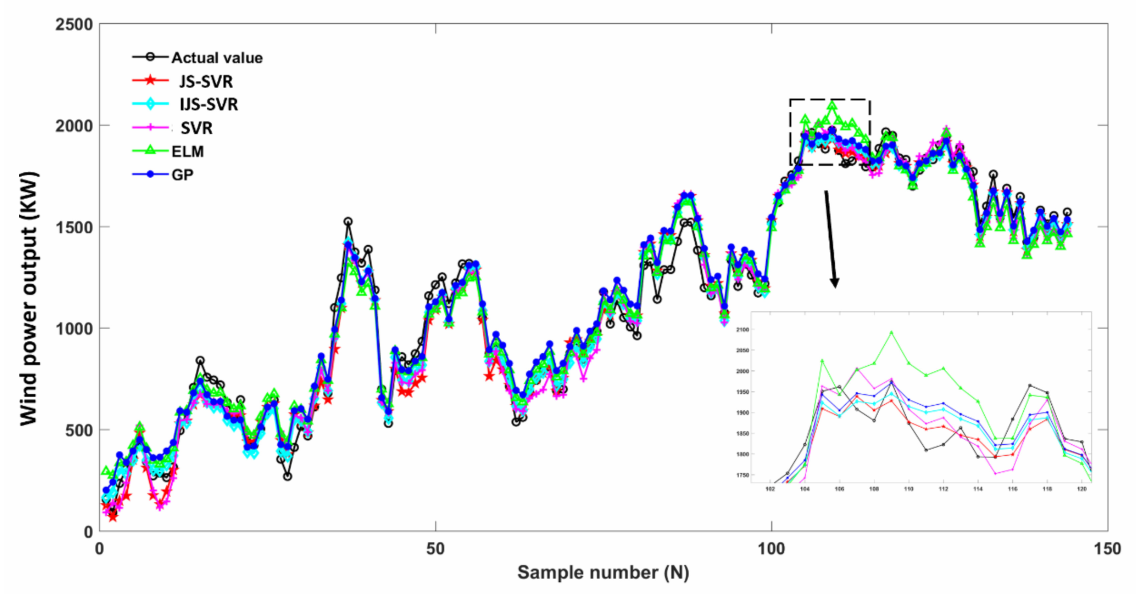
Figure 6. Prediction results of each prediction model in winter.